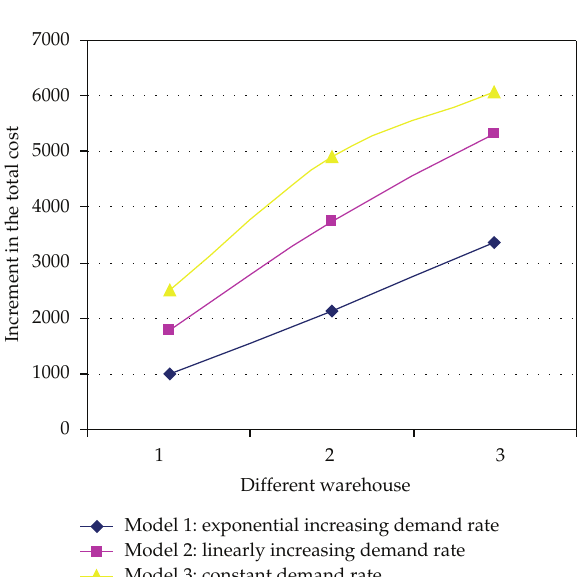
Model 1: exponential increasing demand rate Model 2: linearly increasing demand rate Model 3: constant demand rate Figure 5: Graphical representation of total cost for di ff erent demand